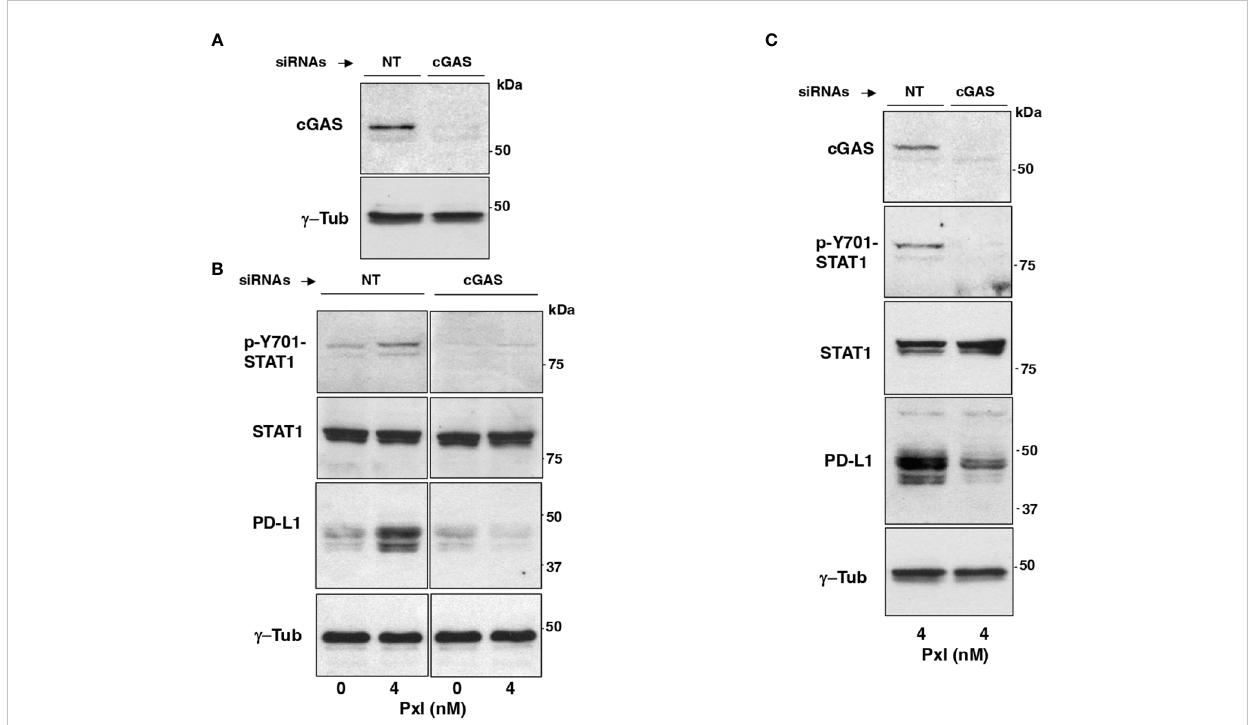
FIGURE 4 Pxl induction of STAT1 phosphorylation and PD-L1 upregulation require cGAS. (A, B) MDA-MB231 cells were treated with non-targeting (NT-siRNAs) or cGAS-targeting small interfering RNAs (cGAS-siRNAs) 24 hours before vehicle (DMSO; 0 nM Pxl) or Pxl (4 nM) addition, then, cells were taken after further 48 hours incubation. (A) The siRNAs treatment resulted in more than 90% downregulation of the cGAS protein expression in cGAS- siRNA-treated cells compared with NT-siRNAs-treated cells. (B) Lysates of NT-siRNA- or cGAS-siRNA-treated cells treated with vehicle (DMSO; 0 nM Pxl) or Pxl (4 nM) were probed for the indicated antigens. (C) A549 cells were treated with non-targeting (NT-siRNAs) or cGAS-targeting small interfering RNAs (cGAS-siRNAs) 24 hours before Pxl (4 nM) addition. Cells were further incubated for 48 hours, then, lysed and proteins probed for the indicated antigens. The blots shown are representative of three independent experiments giving similar